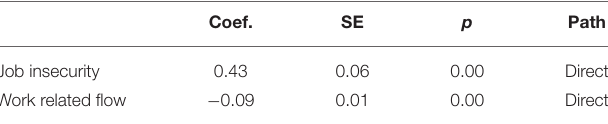
TABLE 4 | SEM paths (predicting financial anxiety).